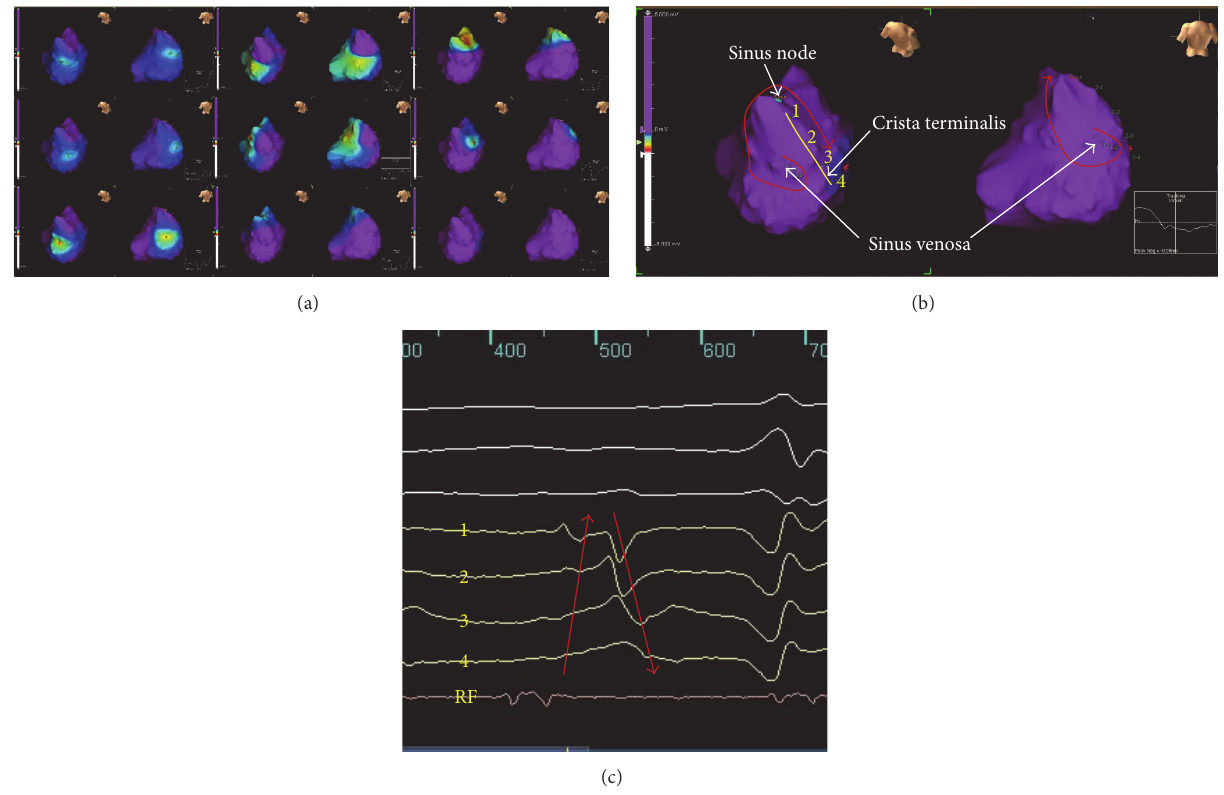
Figure 2: (a) Activation mapping in right atrium revealed that the earliest activation site was sinus venosa. (b) The activation site was moved to the high right atrium and down along the crista terminalis. (c) Virtual unipolar electrogram on the crista terminalis. Red arrow = traces of the movement of activation site; yellow line = crista terminalis; RF = ablation catheter (crista